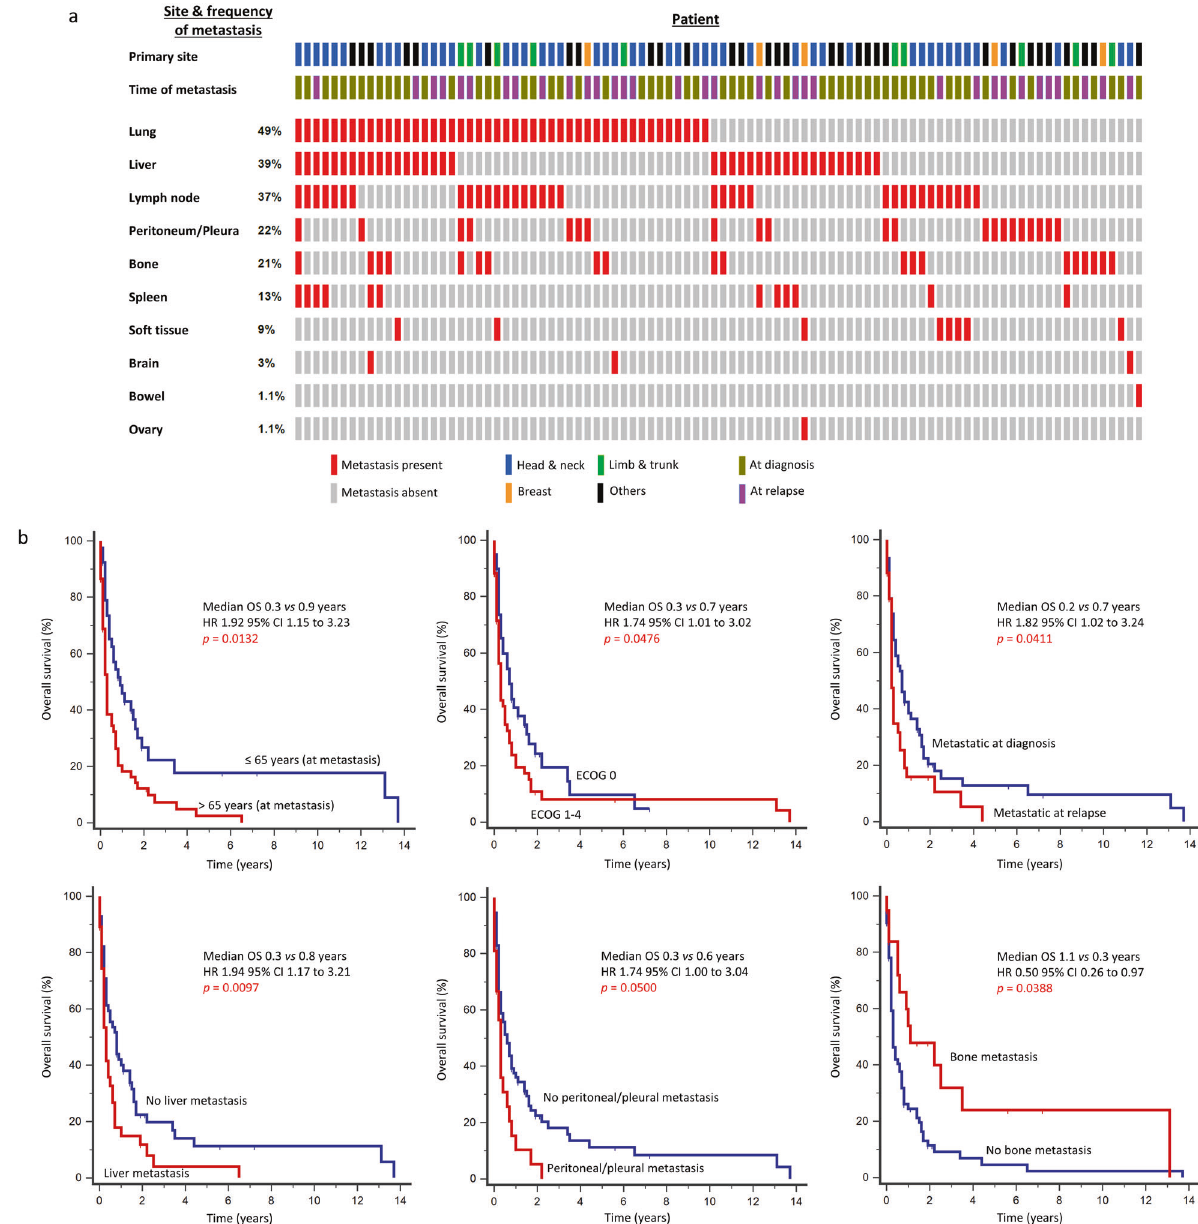
Fig. 2 Patterns of dissemination and survival outcomes of metastatic angiosarcoma. a The commonest sites of metastases include the lungs (49%), liver (39%), and lymph nodes (37%). b Independent predictors of poor OS at the time of metastasis include age >65 years, poor performance status (ECOG 1 – 4), metastasis at relapse, and the presence of liver or peritoneal/pleural metastases. The presence of bone metastasis was associated with better